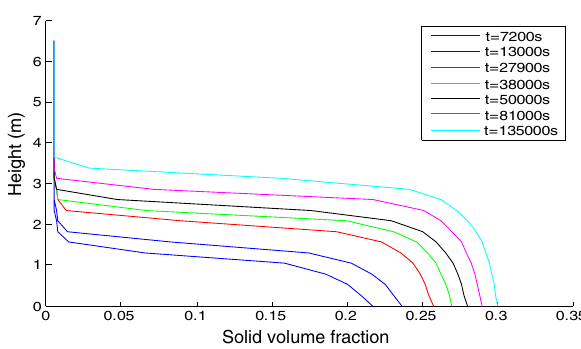
Fig. 3 Results of dynamic simulation for the d 80 = 275 l m, F = 40 g/t and constant pH 2 ( Q F = 0.465 m 3 /s, u F = 0.027, Q D- = 0.0358 m 3 /s)